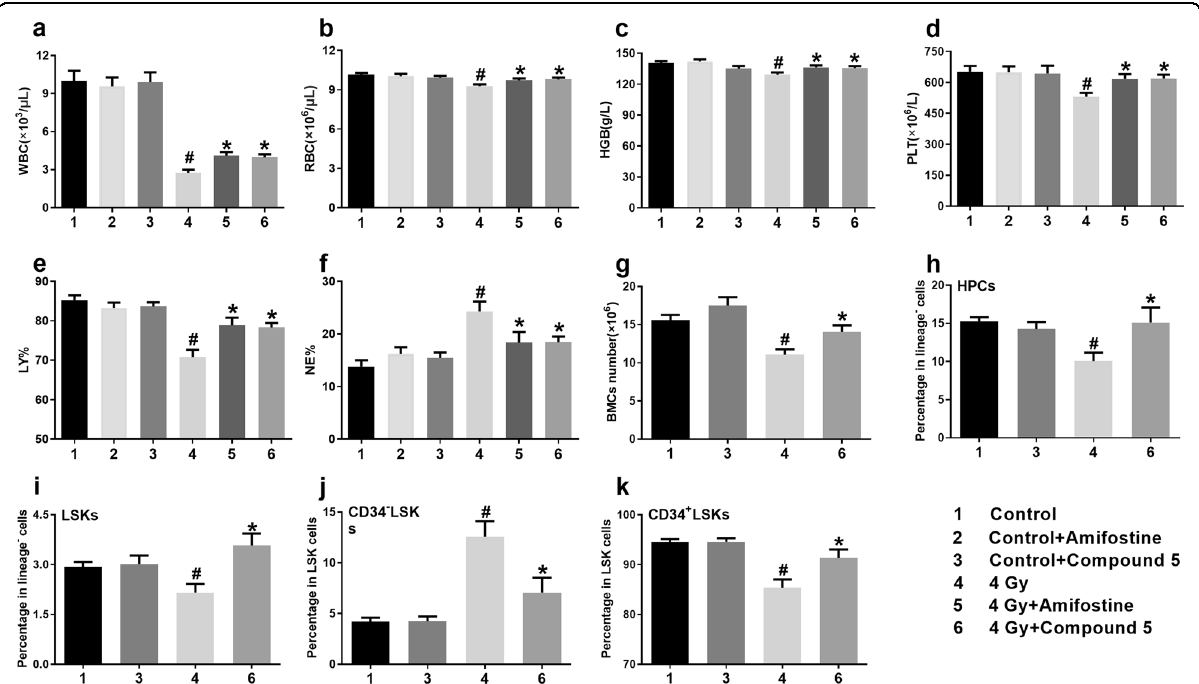
Fig. 4 Compound 5 alleviated TBI-induced hematopoietic system injury. Mice were administered with NS, compound 5 , and amifostine 20 min before exposure to 4 Gy TBI as described in the “ Materials and methods ” section; control mice were sham-irradiated. a White blood cells (WBC) count; b red blood cells (RBC) count; c hemoglobin (HGB) count; d platelet (PLT) count; e lymphocyte (LY) percentage; f neutrophil (NE) percentage; g BMCs number; h HPCs percentage; i LSKs percentage; j CD34 − LSKs percentage; k CD34 + LSKs percentage; # p < 0.05 vs Control, * p < 0.05 vs 4 Gy, N = 25 in group a – f , N = 5 in group g – k